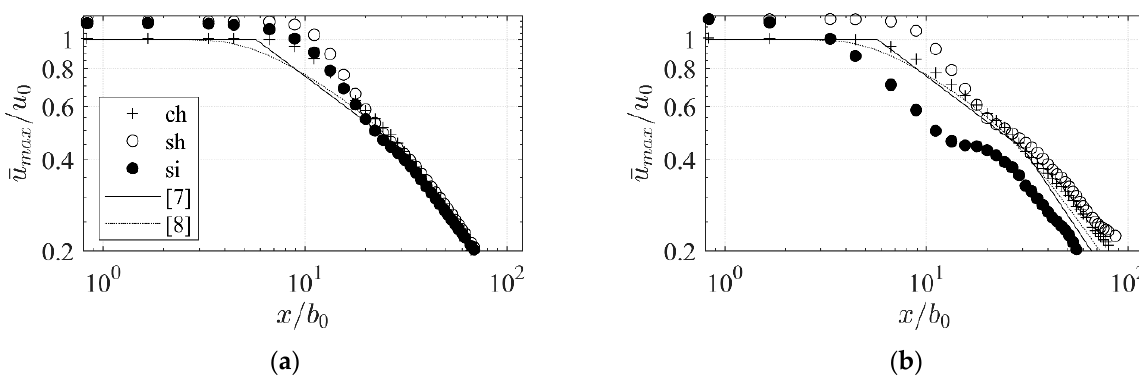
Figure 14. Downstream evolution of the mean maximum streamwise velocity u max / u 0 in yz-planes in distances from the orifice; ( a ) simulation with RANS (kw-SST turbulence model); and ( b ) simulation with DES. Analytical models are given for comparison: [7,8].